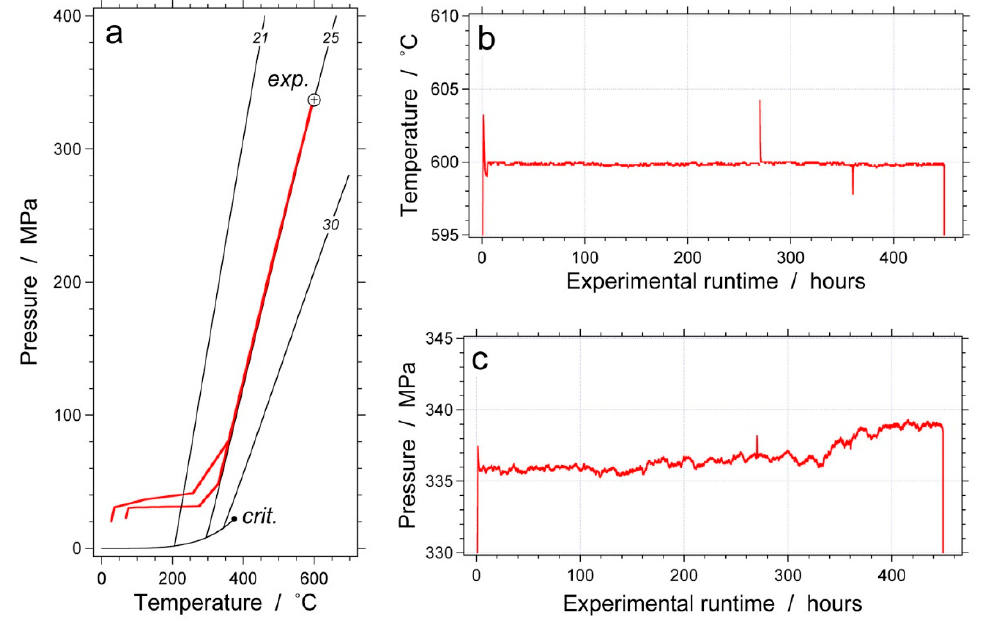
Figure 2. Example of a log-file of a fluid inclusion synthesis experiment. The red line illustrates the recorded temperature, pressure and run time: ( a ) temperature-pressure diagram with the isochores 21, 25 and 30 cm 3 /mol of pure H 2 O and the liquid-vapor curve with the critical point (crit.); ( b ) experimental runtime-temperature diagram; ( c ) experimental runtime-pressure diagram illustrating a minor increase in pressure.